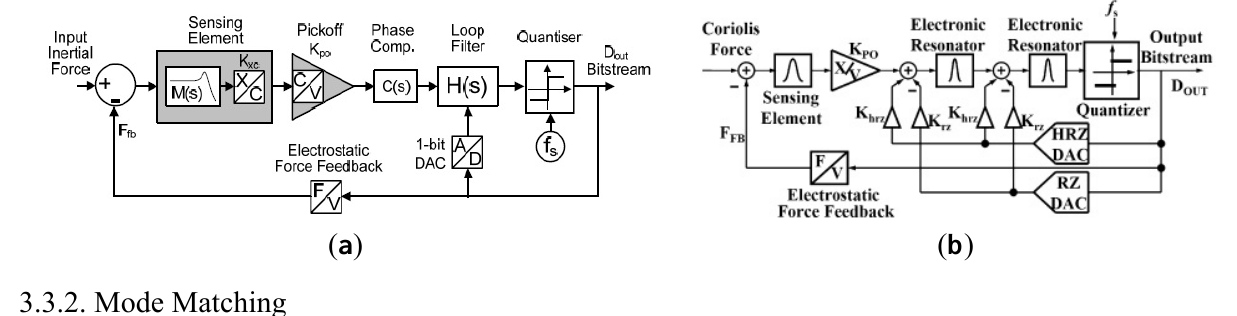
Figure 37. University of Southampton ΣΔ modulation circuitry. ( a ) The schematic